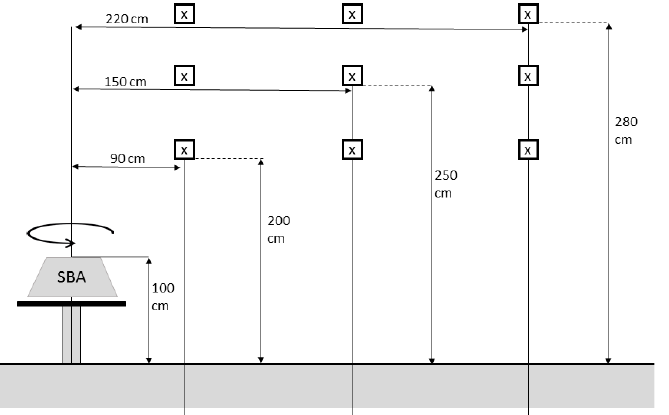
Figure 12. Schematic diagram of the SBA and transmitting antennas experimental relative